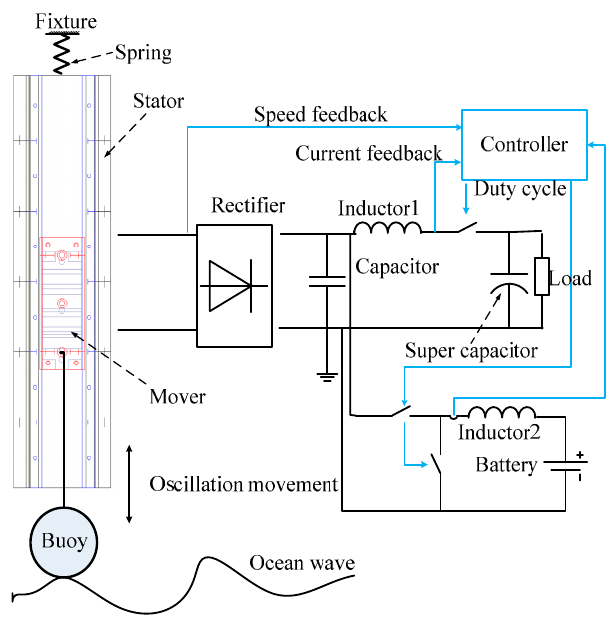
Figure 1. Schematic blocks of overall wave power generation and storage.